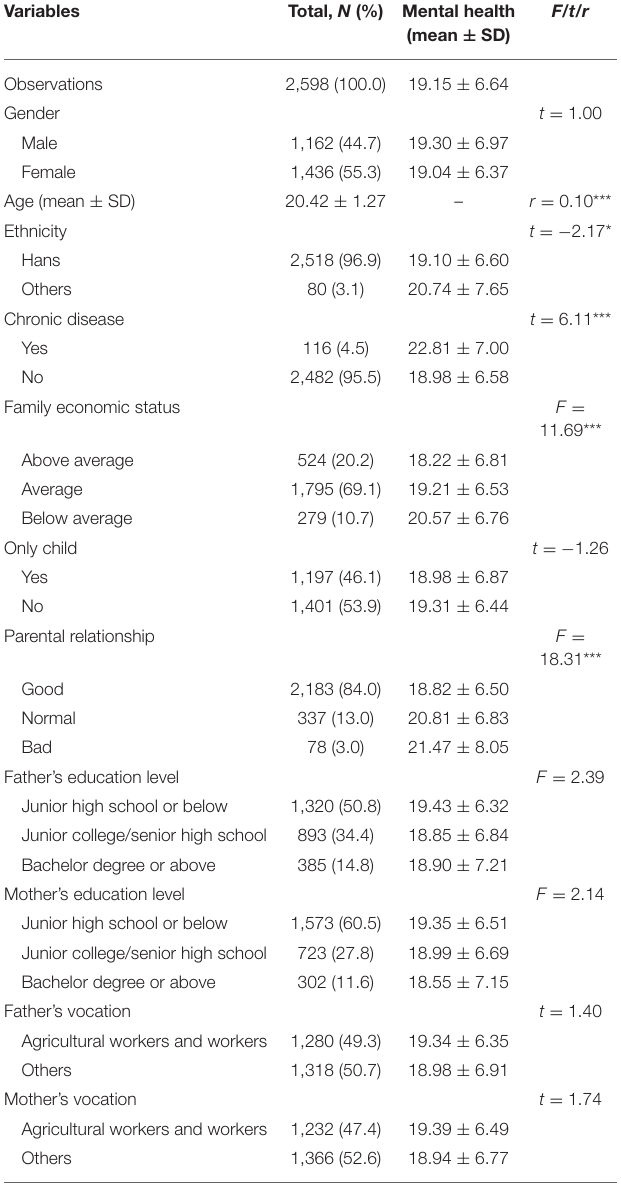
TABLE 1 | Description and single analyses for the association between sociodemographic factors and mental health.